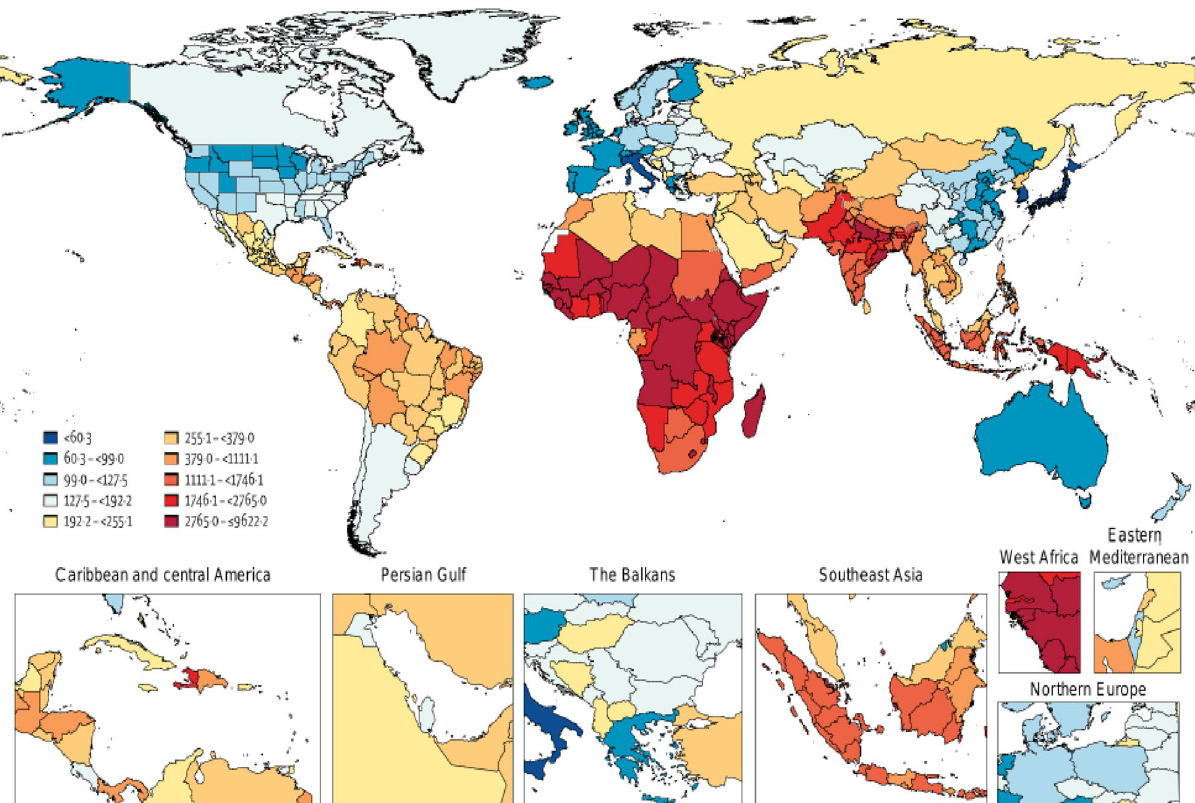
Figure 1. Age-standardized DALY rates (per 100 000) by location, both sexes combined, 2019 (source: https:// www. healt hdata. org/ resul ts/ gbd_ summa ries/ 2019/ enter ic- infec tions- level-2- cause) 2